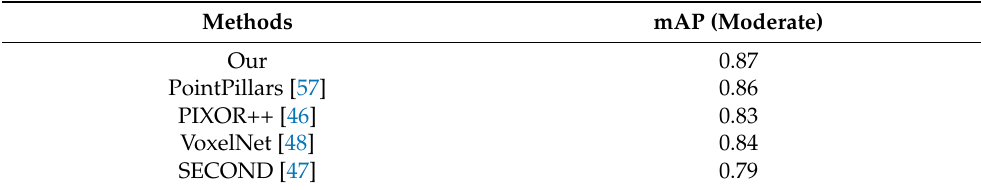
Table 4. Medium average precision results.